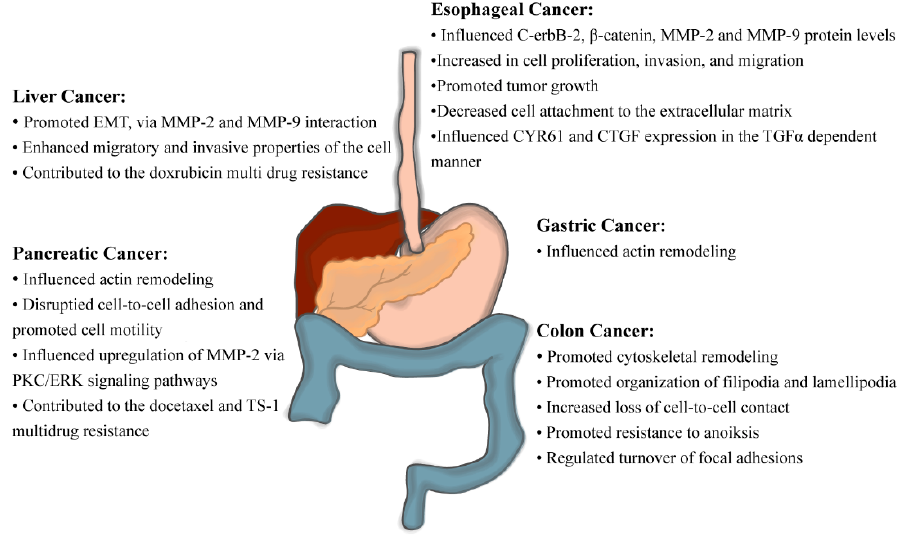
Figure 3. The biomarkers that can be utilized alongside fascin-1 IHC to improve the diagnostic po- tential of fascin-1. +, positive correlation; -, negative correlation.